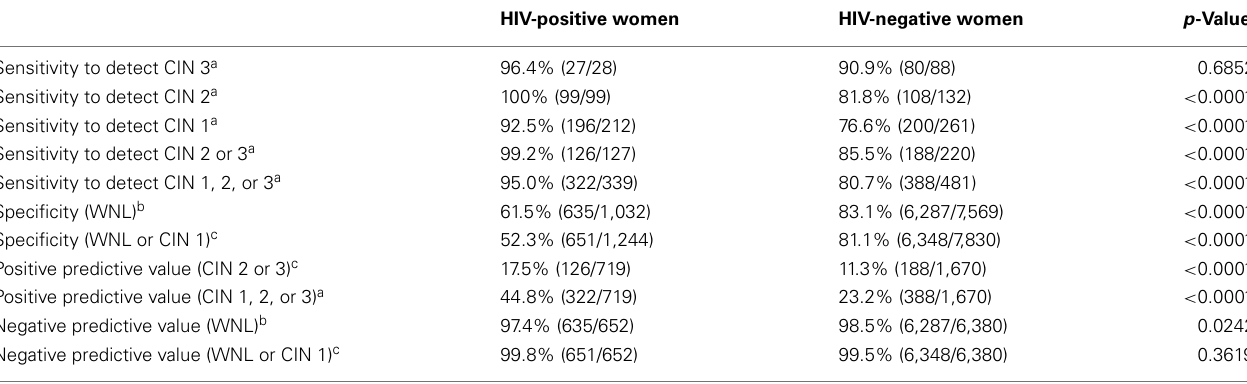
Table 2 | Performance characteristics of HPV DNA testing using HC2 to detect different grades of disease among 1,371 HIV-positive and 8,050 HIV-negative